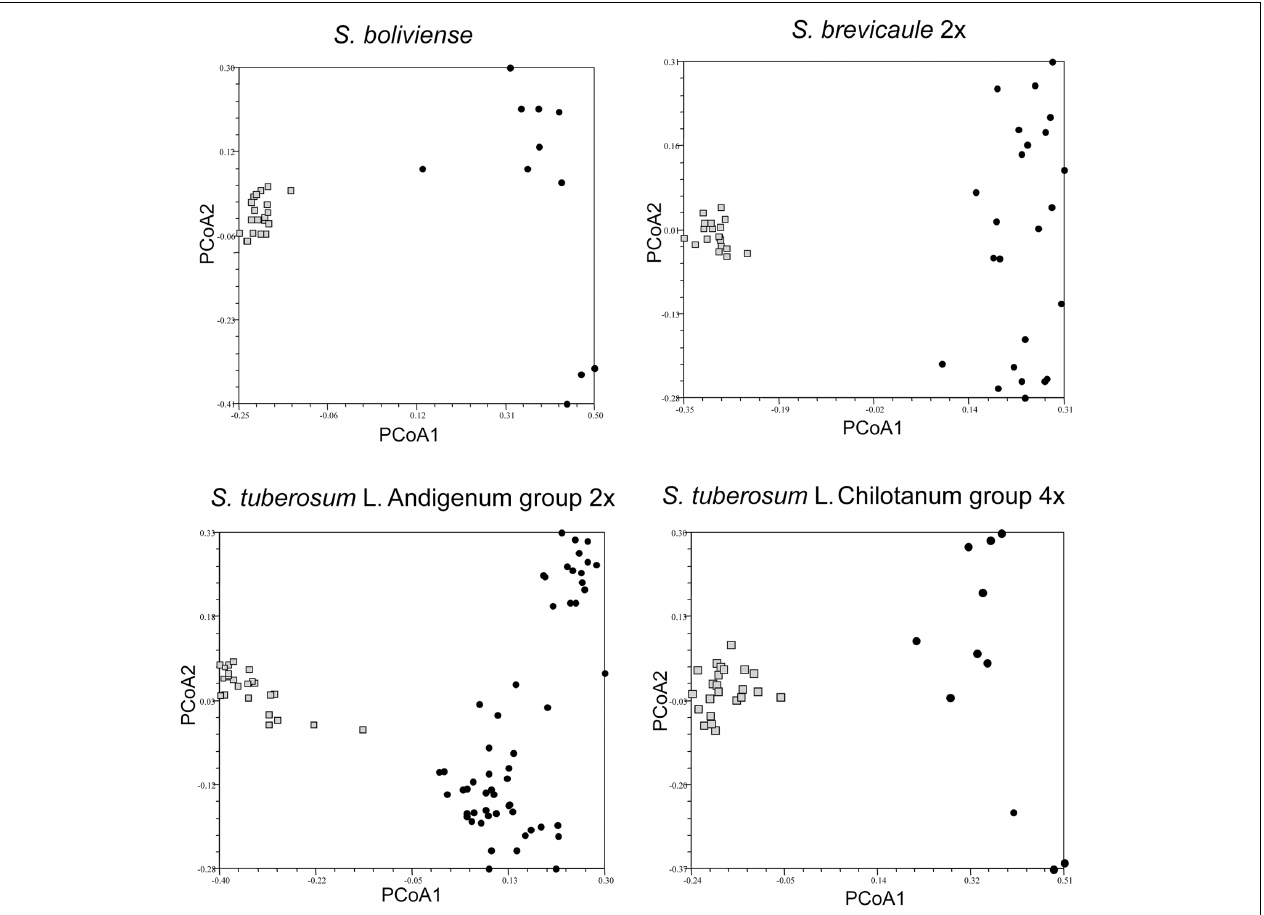
FIGURE 3 | Principal coordinate analysis showing clustering of individuals in single genebank accessions of self-incompatible species Solanum boliviense , S. brevicaule 2x, S. tuberosum Andigenum group (2x), S. tuberosum Chilotanum group (4x) relative to a broader species sample, represented by single individuals from several genebank accessions. The relevant accessions are shown as lightly shaded (squares and triangles); the individuals representing the taxon as black